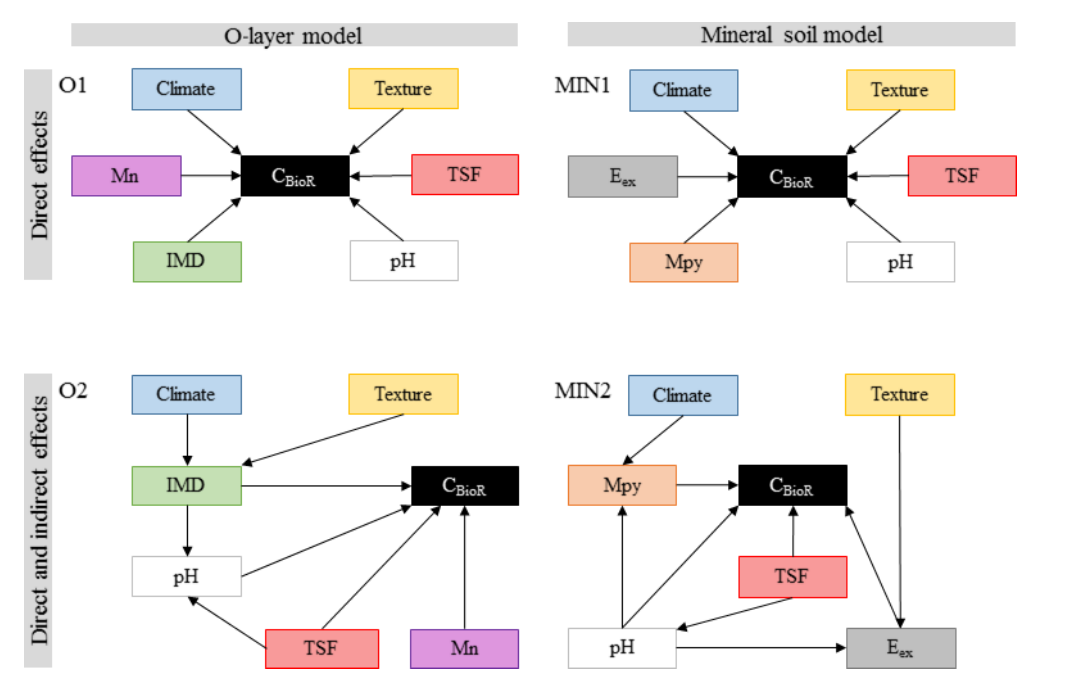
Figure 2. Path models for each of the multivariate causal hypotheses. Arrows indicate direct causal relationships. Climate: climate variable; texture: texture variable; TSF: time since fire; pH: pH of the O layer (O1 and O2) or of the top 35cm of mineral soil (MIN1 and MIN2); IMD: index of moss dominance; Mn: exchangeable manganese of the O layer; Mpy: pyrophosphate-extractable metals; E ex : exchangeable element (Al or Mn) of the mineral